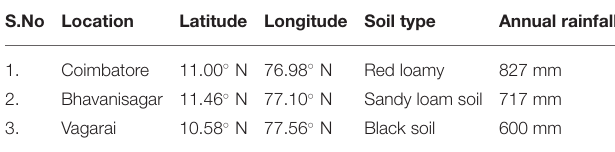
TABLE 2 | Description of the three locations in